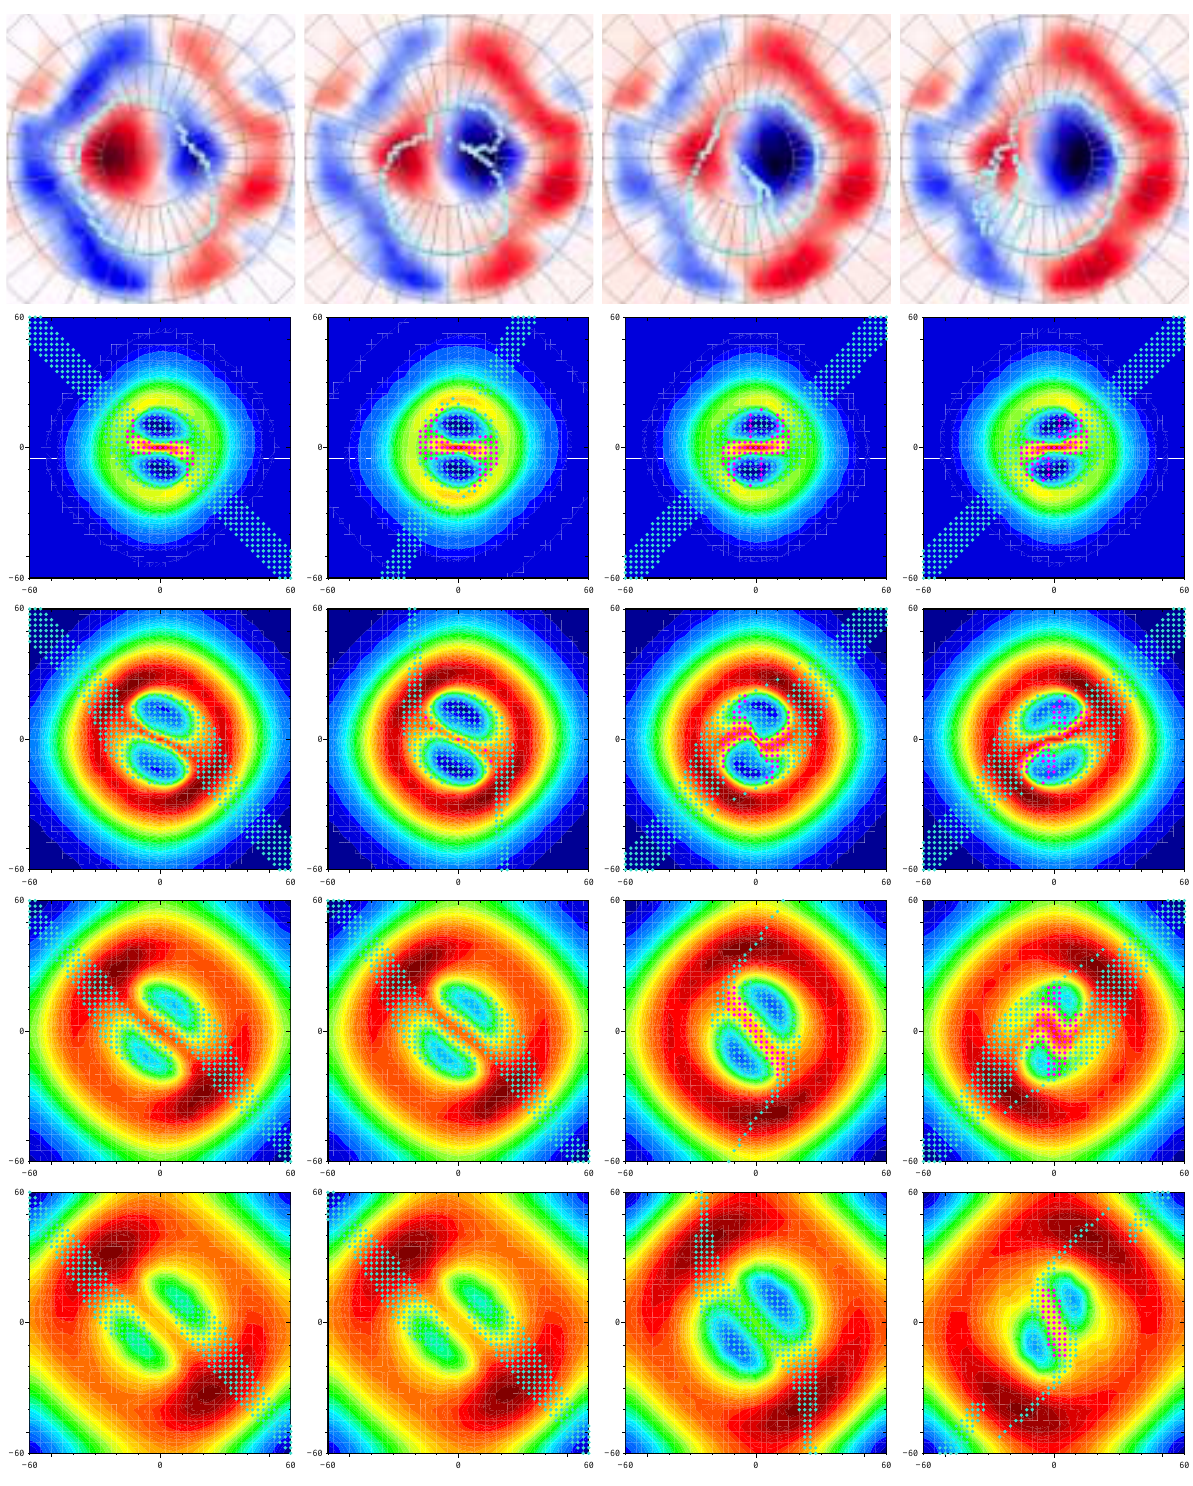
Fig. 1. Simulation results after two hours constant IMF. The columns (from left to right) show the magnetosphere for IMF clock angles of 100 ◦ , 80 ◦ , 45 ◦ and 10 ◦ and an IMF magnitude of 5.1nT (runs 1a, 1b, 1c and 1d). The first row contains plots of the northern ionosphere with the open/closed field line boundary (light blue line) overlaid on the upward (blue) and downward (red) field-aligned currents. The plots give a 2-D view on the polar cap in geomagnetic coordinates with noon pointing to the top. The second to last row show tail cross sections at x =− 10 ,x =− 30 ,x =− 60 and x =− 120 R E (looking downtail in GSM coordinates). In the tail plots the regions of closed (pink dots) and open field lines (light blue dots) are overlaid on plasma pressure isocontour lines (in arbitrary